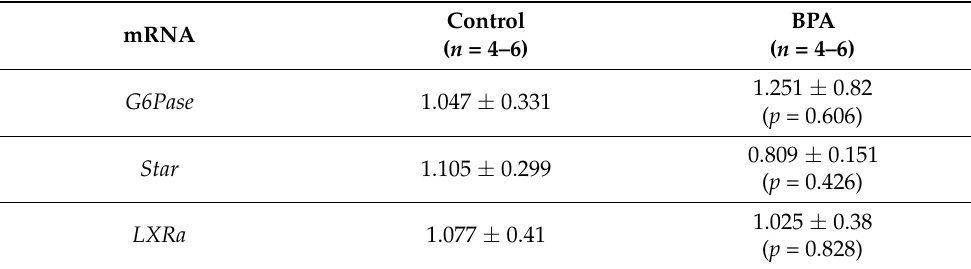
Data are expressed as normalised fold expression ±